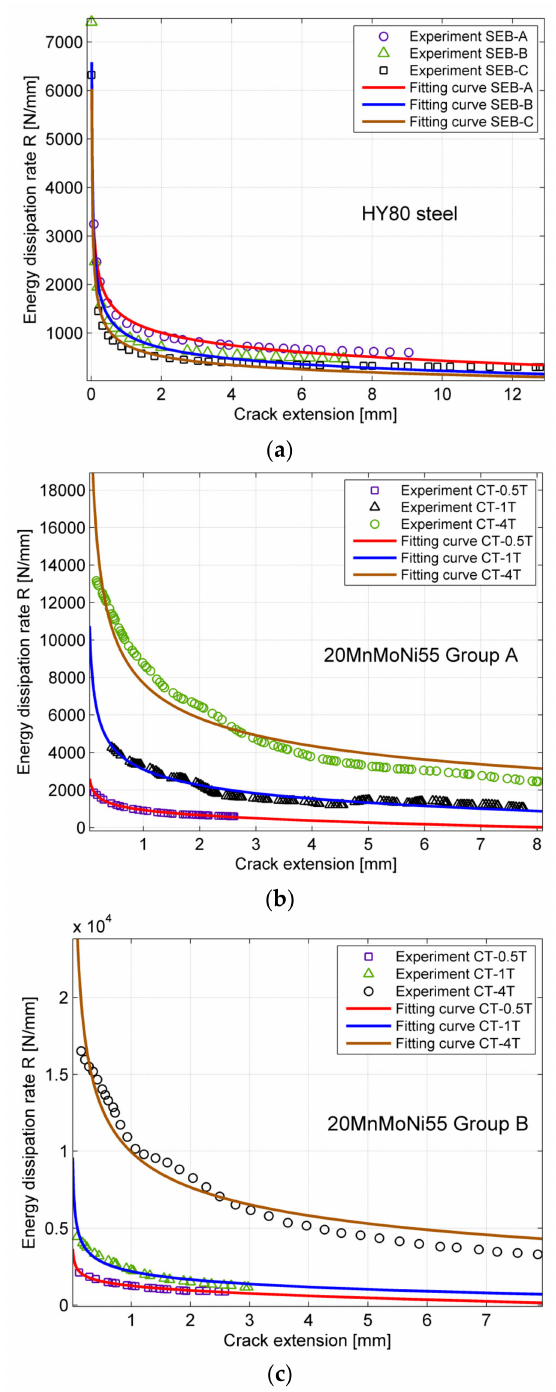
Figure 2. Fitting results of R( ∆ a )‑curve by the proposed theory for ( a ) HY80, ( b ) 20MnMoNi55 Group A, and ( c ) 20MnMoNi55 Group